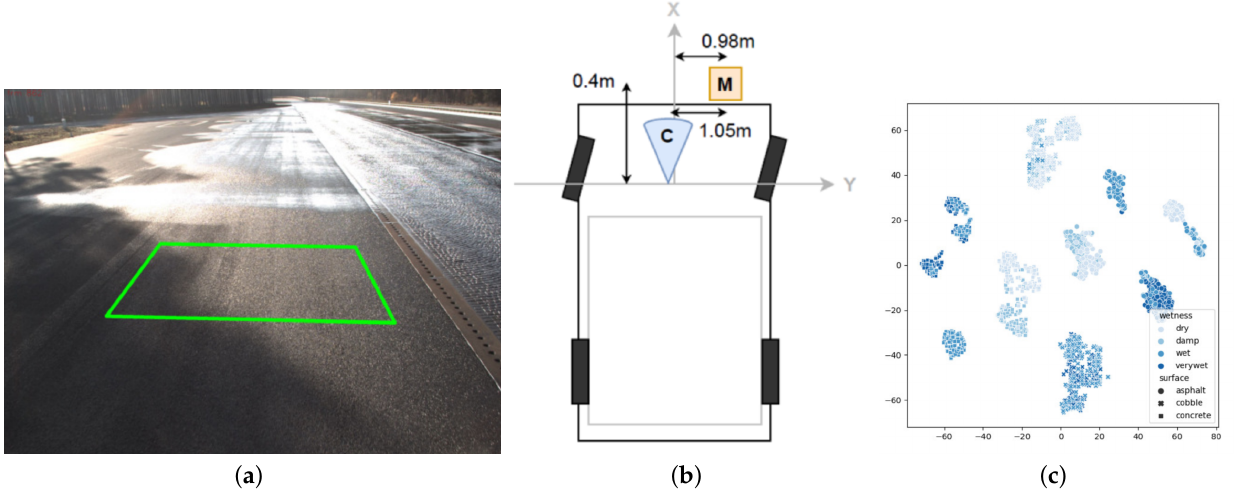
Figure 12. Kai Cordes dataset collection process. ( a ) Schematic representation of the area from which the data set was collected. ( b ) Location of the detection equipment mounted on the vehicle. The orange square Marwis is located at the bottom right of the vehicle, and the blue cone C shows the camera mounted at a fixed height above the car; ( c ) Visualisation and analysis of the RoadSaW dataset based on the use of t-SNE. The three surfaces, namely, asphalt, cobble, and concrete, are indicated by different markers. The four subcategories, namely, dry, wet, wet, and very wet, are shown with four shades of blue